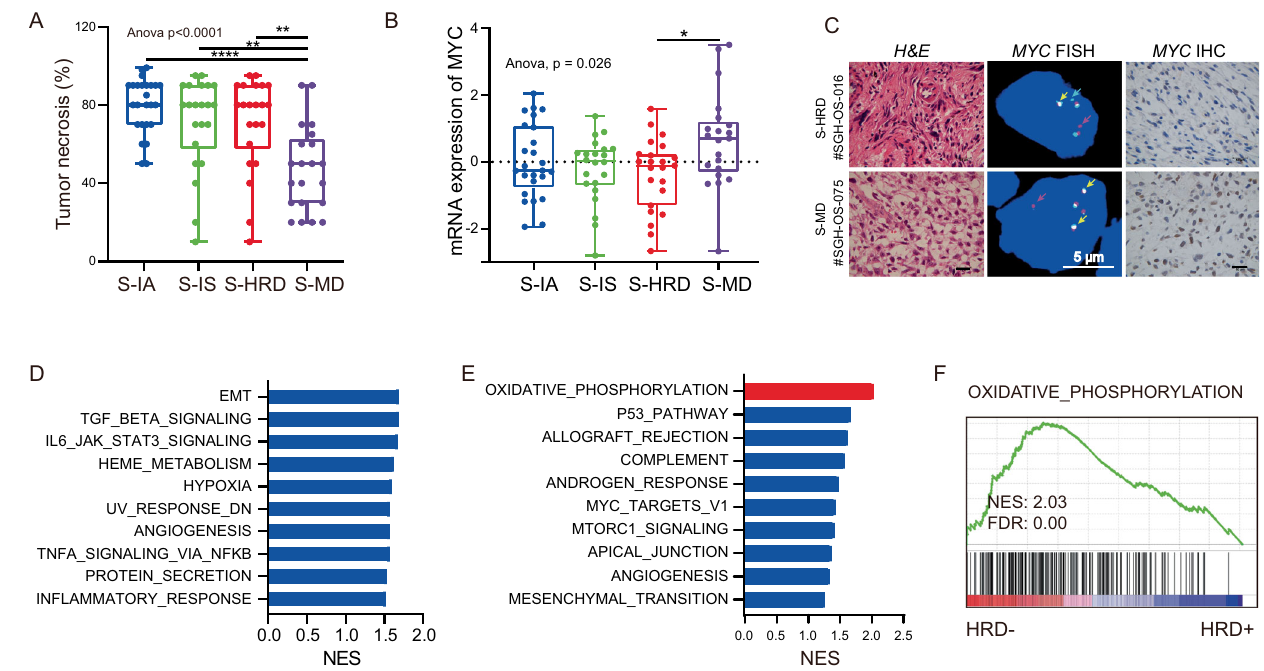
Fig. 5 | MYC ampli fi cation with HR pro fi ciency was associated with OXPHOS activation and poor prognosis. A Comparison of the tumor necrosis rate among integrative subtypes. The statistical analysis was made by ANOVA with Tukey ’ s multiple comparisons test. ( P <0.0001). B Gene expression level of MYC in each subtype.TheStudent ’ s t testwasadoptedinsigni fi cantdifferenceanalysisbetween